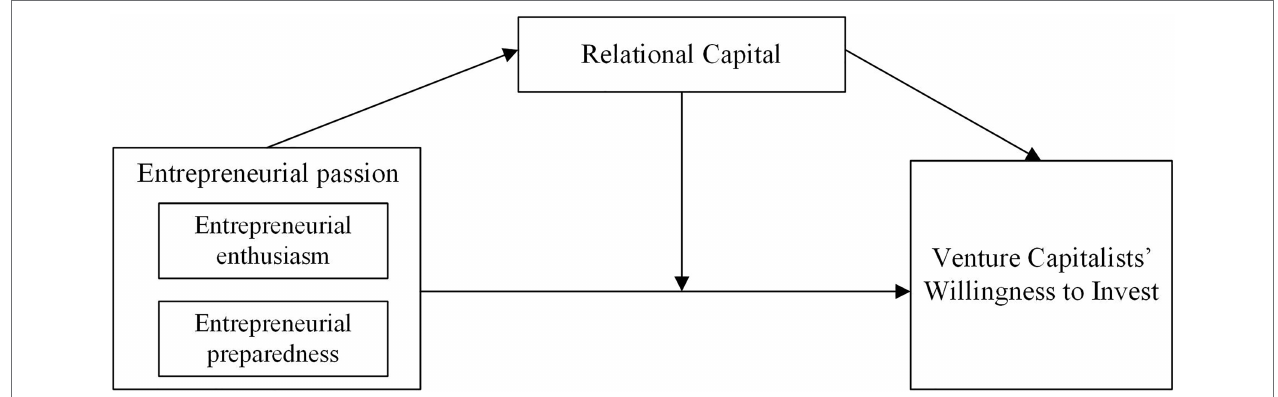
FIGURE 1 | Theoretical model.